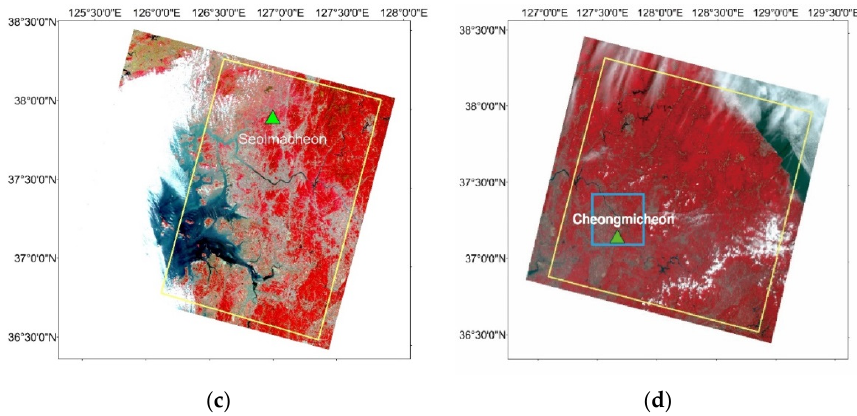
Figure 2. Landsat 8 OLI color-infrared images for: ( a ) Site 1, image collected on 6 August 2013; ( b ) Site 2, image collected on 21 July 2013; ( c ) Site 3, image collected on 11 May 2013; and ( d ) Site 4, image collected on 5 June 2013. Yellow outlines show the boundary of the study area, blue rectangles show the areas around flux towers of sites 2 and 4, and green triangles indicate the location of flux towers. Table 1. Landsat 8 images and MOD16A2 products for all sites. Site